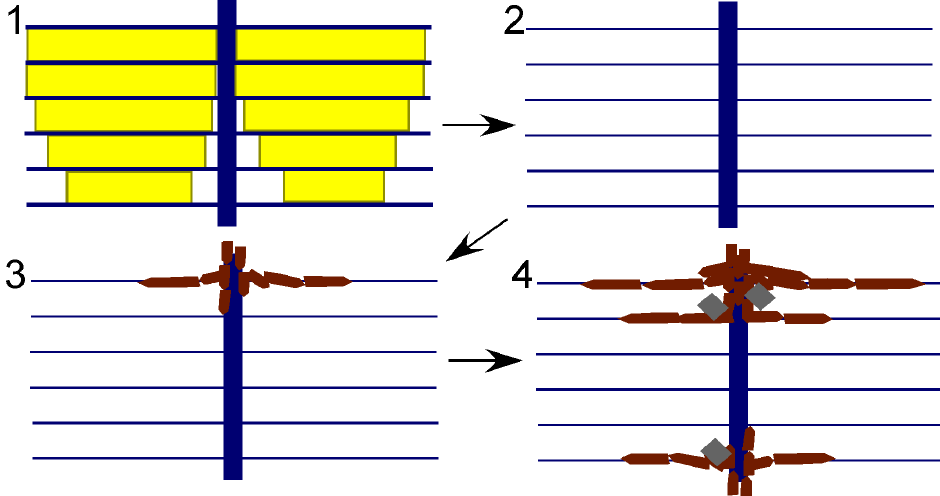
Figure 5. Model for preservation of nacre in Isorthoceras from the Maquoketa Formation. External shell surface is above, internal surface below. Key: yellow shows original aragonitic nacre tablets; blue shows organic matrix; white is empty space; burgundy polygons represent secondary phosphate; and grey rhombohedra are secondary